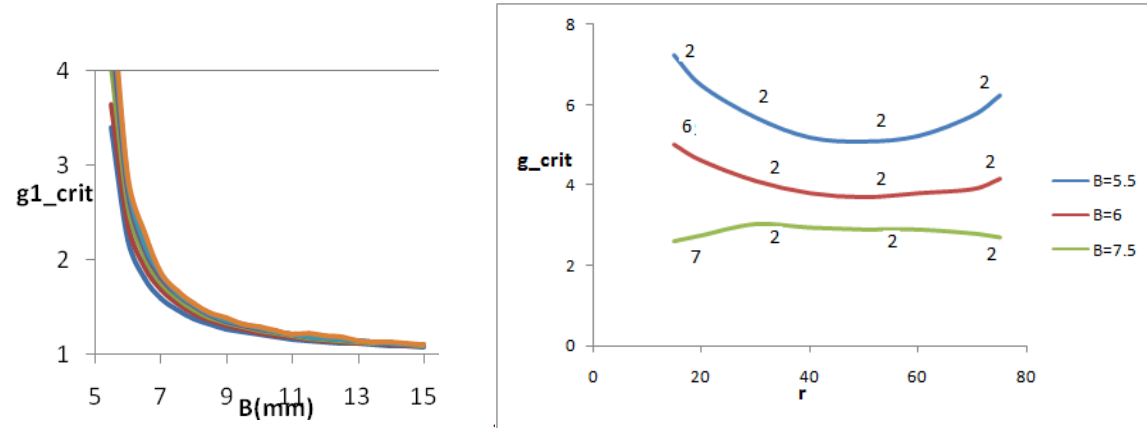
. Figure 13: Effect of proliferation region width. A=5mm, C=50mm(large enough to simulate infinity). (a) Fixed outer boundary simulating stiff skin. Critical radial growth rate vs. proliferation region width. (b) Enforced circular outer boundary simulating loose skin. Critical radial growth rate(and buckling mode as the numbers indicate) vs. fiber